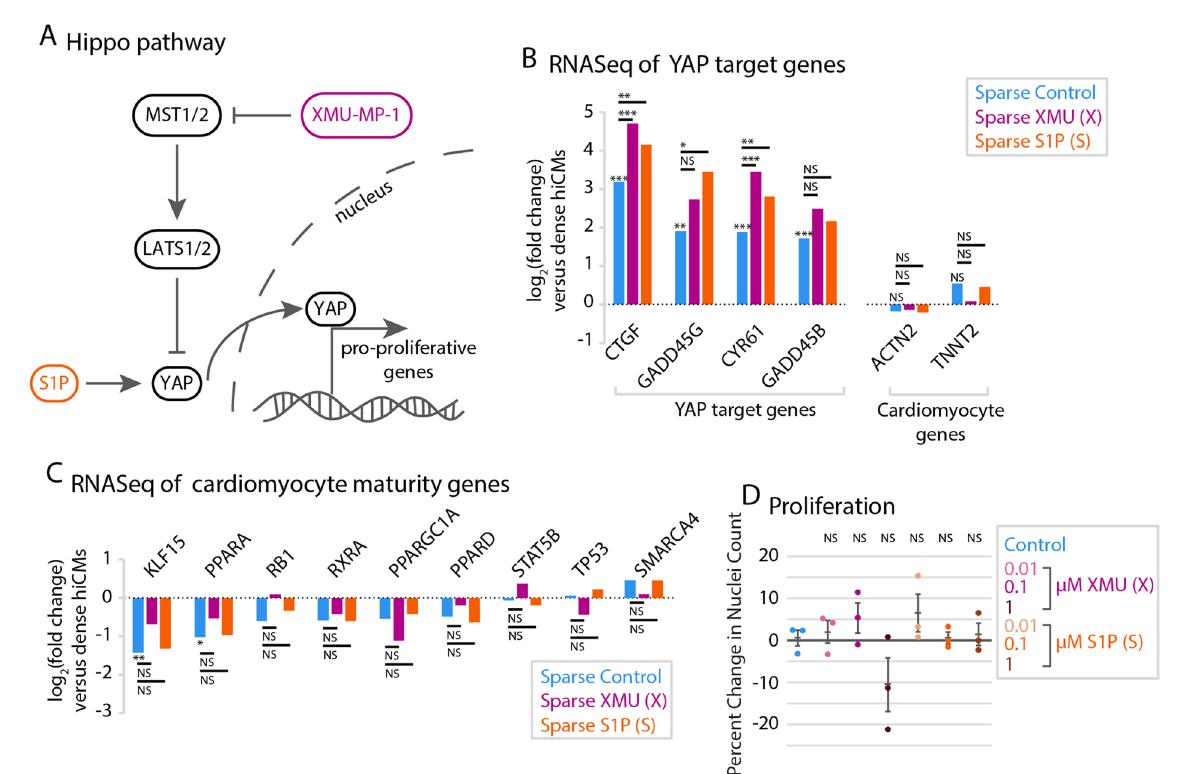
Figure 3. Individual pharmacological perturbation of the Hippo pathway increases YAP target genes but does not affect proliferation. ( A ) Schematic of the Hippo pathway. ( B ) RNASeq data of YAP target genes in sparse cells with treatment of 1 µM XMU-MP-1 or 1 µM S1P. A negative fold change represents a downregulation in treated cells, whereas a positive fold change represents an upregulation in treated cells. N = 300,000 cells per treatment, over 3 independent experiments and RNA preparations. Right: cardiac myocyte-specific genes do not change upon small molecule treatment. *p < 0.05, **p < 0.01, ***p < 0.001. All p-values and gene names are available in Tables 1, 2, 3. Differentially expressed genes were determined using the criteria of fold change ≥ 2 and FDR ≤ 0.05. ( C ) RNASeq data of CM-maturity genes as in ( B ). ( D ) Quantification of proliferation of control, XMU-MP-1-, and S1P-treated cells by measuring the percent change in nuclei over 48 h post-treatment. Significance determined by one-way ANOVA with a Dunnett’s post-hoc test corrected for multiple